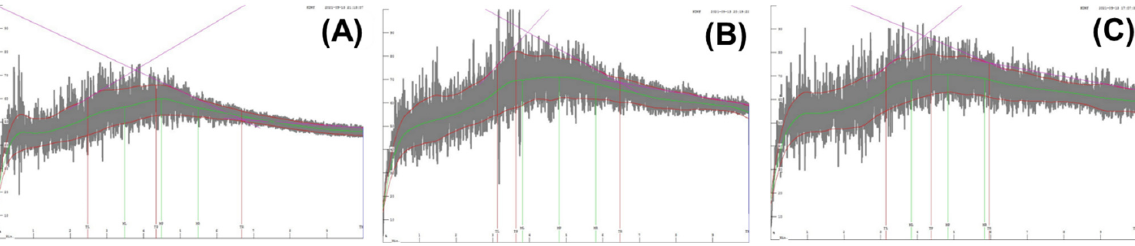
Figure 3. Mixograms of the flour samples: ( A ), ‘O ‐ free’ flour; ( B ), Bread flour A; ( C ), Bread flour B.